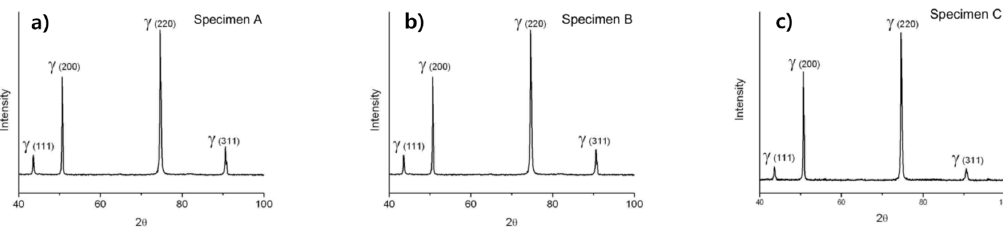
Figure 1. X-ray diffraction patterns of as-received specimens showing the presence of austenite in the initial samples.